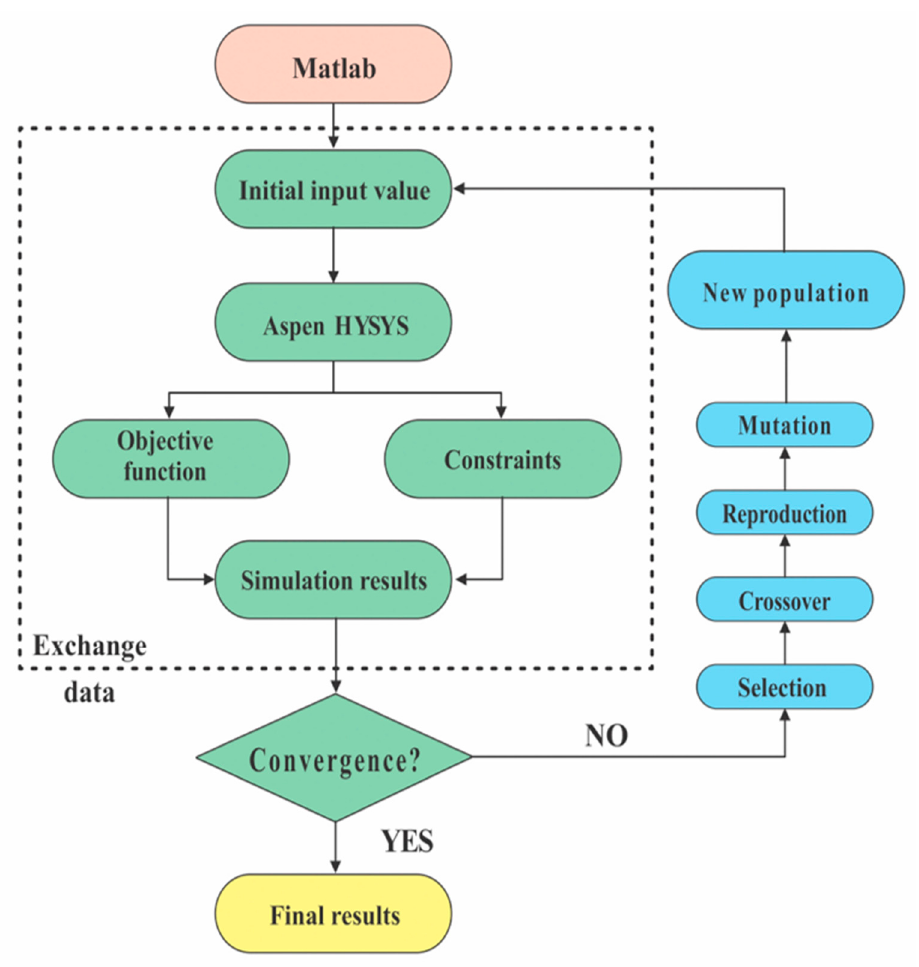
Figure 3. Illustration of the process optimization using GA.